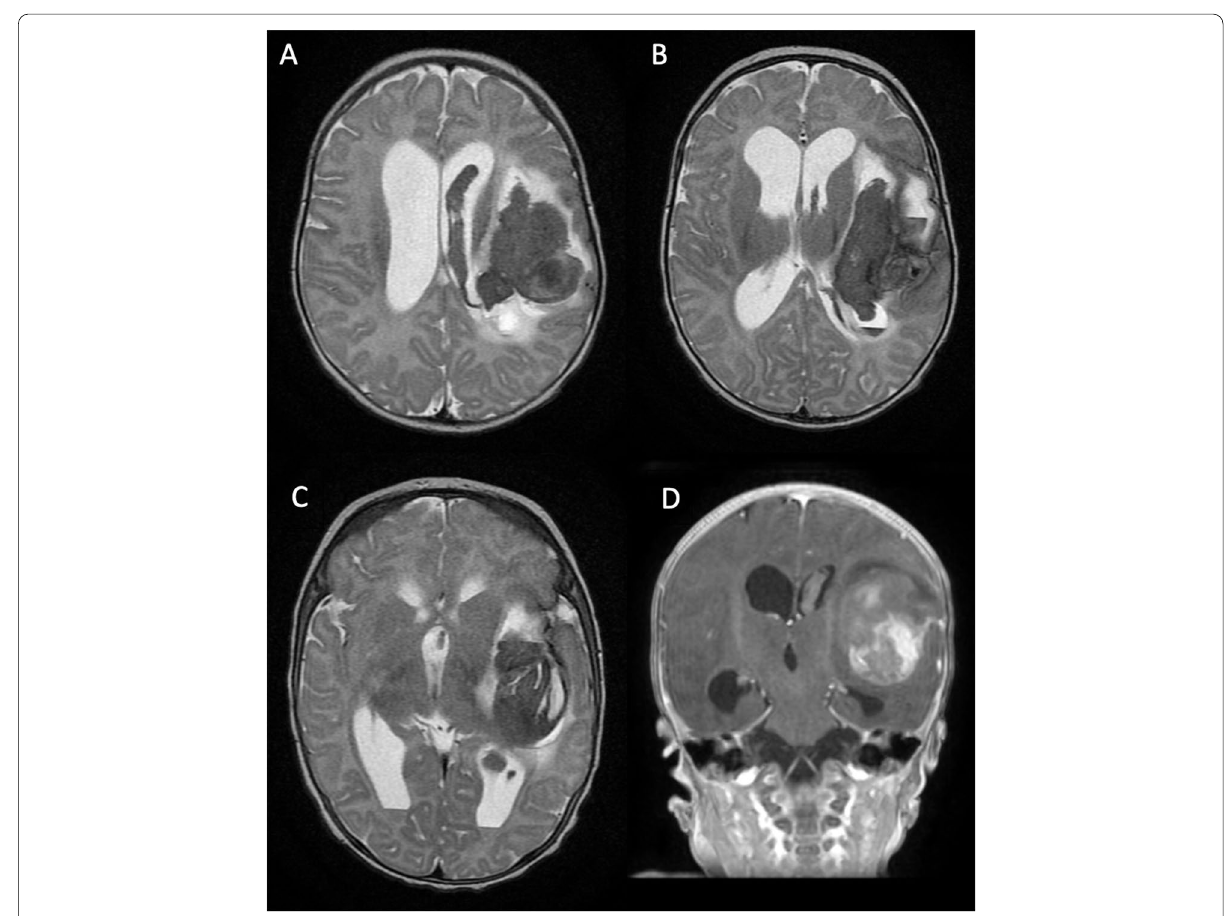
Fig. 1 Brain MR of case 1. A , B , and C Transverse planes. D Coronal plane. Large subacute frontal and left temporal hematoma measuring 6 3.5 cm, open to the ventricular system and subarachnoid space. Dilatation of the lateral ventricles with asymmetry due to the mass effect of the hematoma on the left system